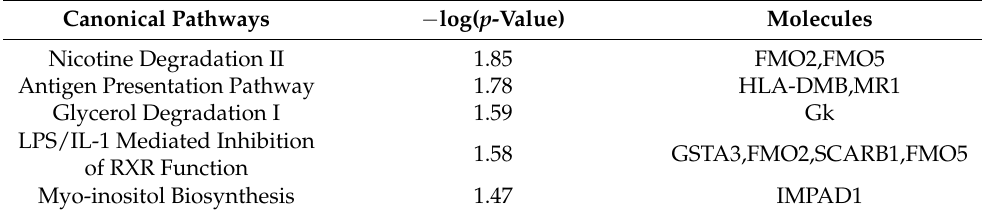
Table 2. Top 5 pathways affected in BAT of Trsp f/f -Ucp1-Cre +/ − mice at room